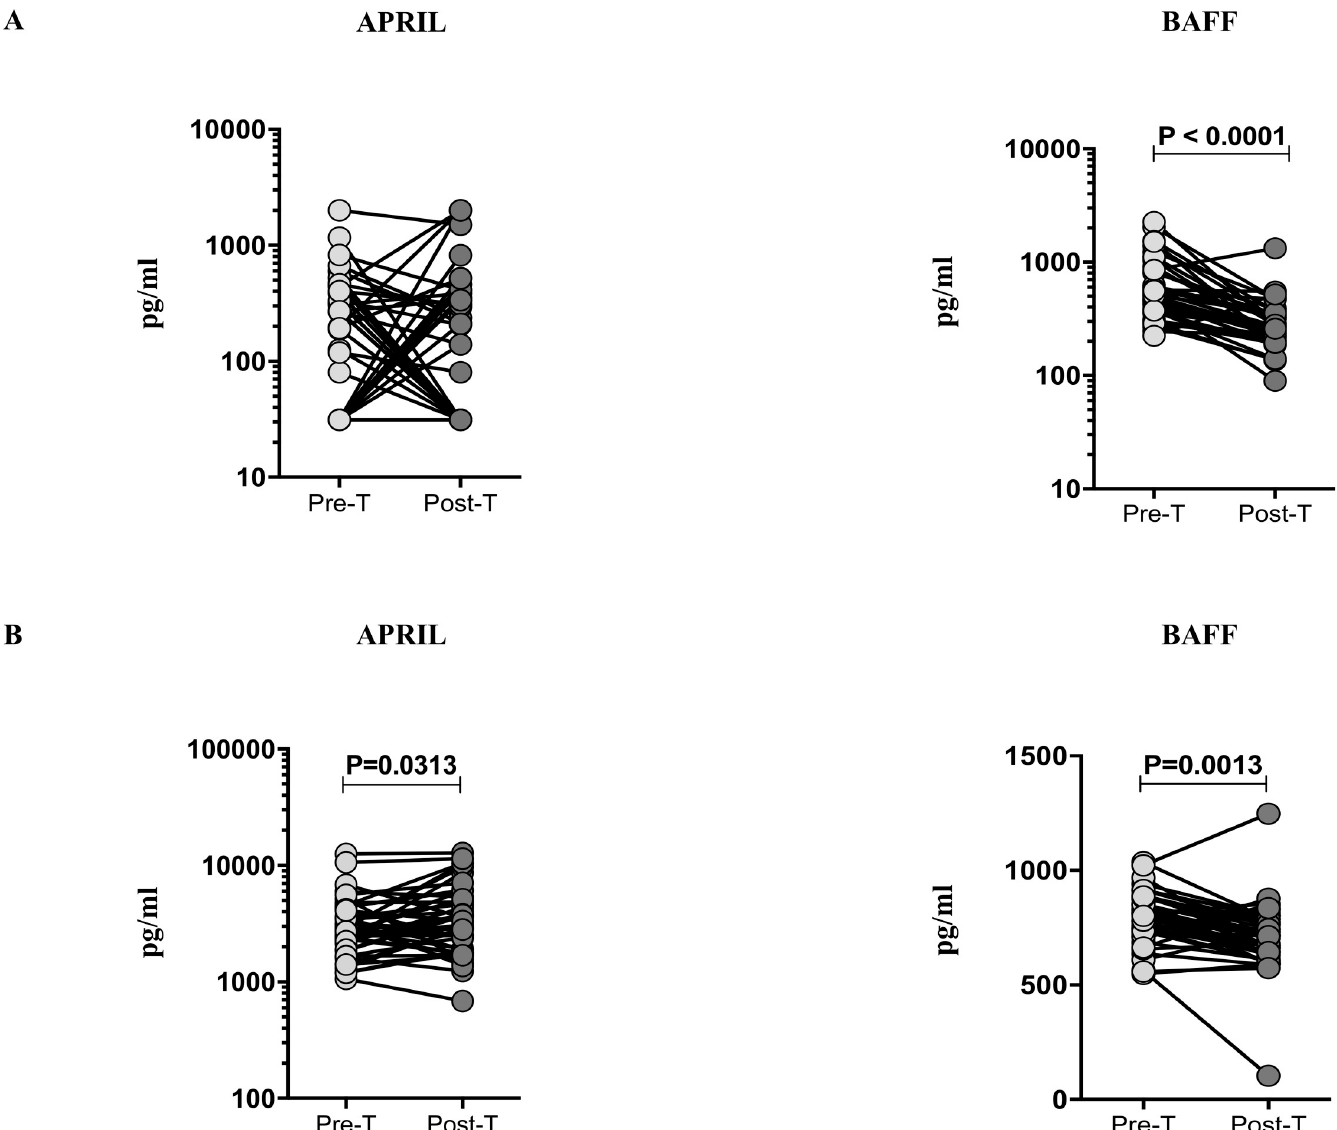
Fig 2. Anti-TB treatment reverses the circulating levels of BAFF in PTB and both APRIL and BAFF in TBL. The plasma levels of APRIL and BAFF (A) PTB (B) TBL were measured in the before (pre-T) and 6 months after (post-T) anti-TB chemotherapy. The data are shown as line diagrams with each line representing a single individual. P values were calculated using the Wilcoxon signed rank